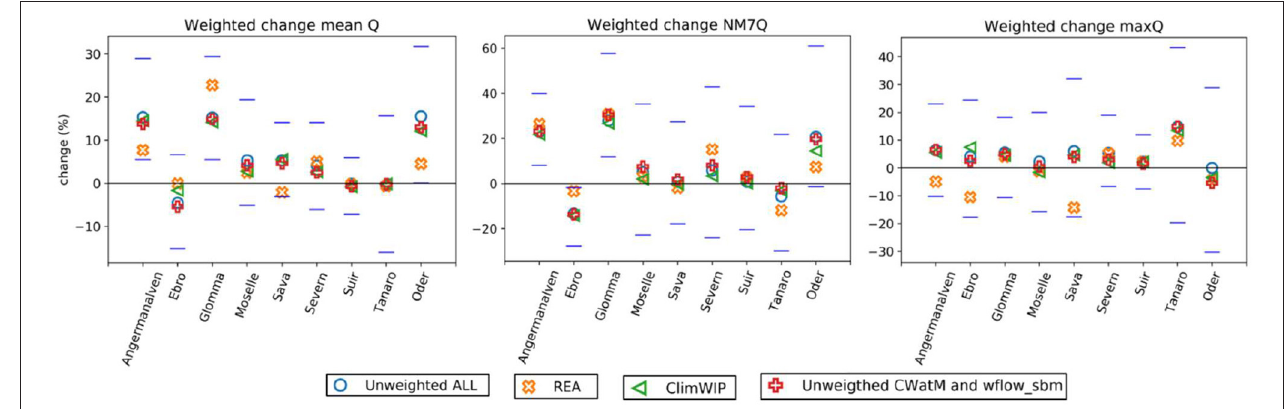
FIGURE 4 | Boxplots representing the projected changes in 7-day low flow for from left to right, the 3 hydrologic models (green), the 7 GCMs (red), the 6 RCMs (blue) and the full set (cyaan). The spread of the boxplots is influenced by the number of available simulations and this number has therefore been added between brackets to the labels of the x-axis.